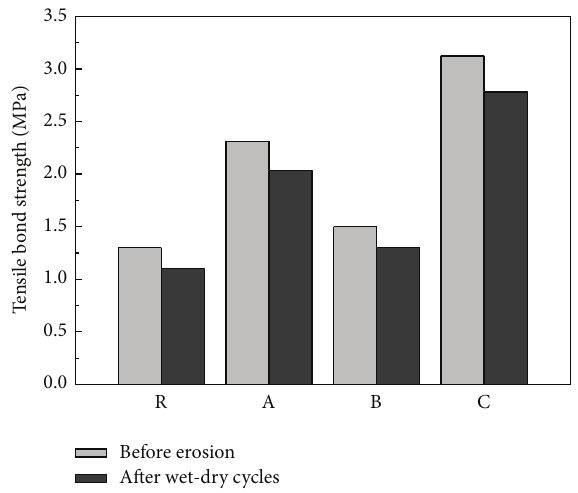
Figure 6: Tensile bond strength of repair mortars before and after wet-dry